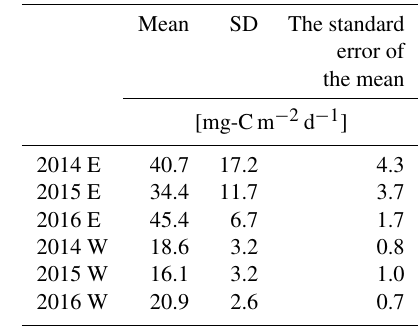
Table 4. CH 4 emission during the peak season. Table 5. CH 4 emission during the winter